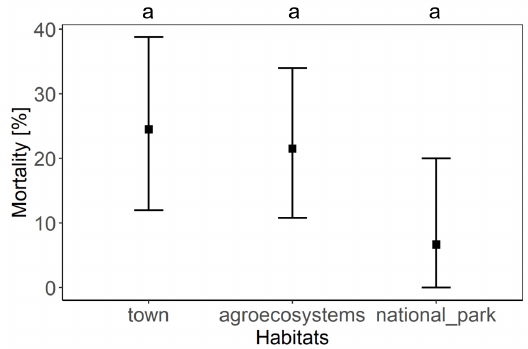
Figure 7. The comparison of honey bee winter mortality rate according to type of habitat. Black squares represent means and the error bars represent 95% confidence intervals.